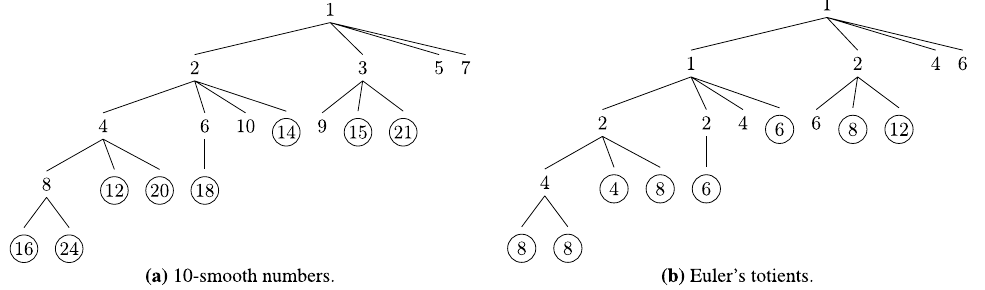
Figure 5. Enumeration of 10-smooth numbers and their Euler’s totients in the interval [11, 24].